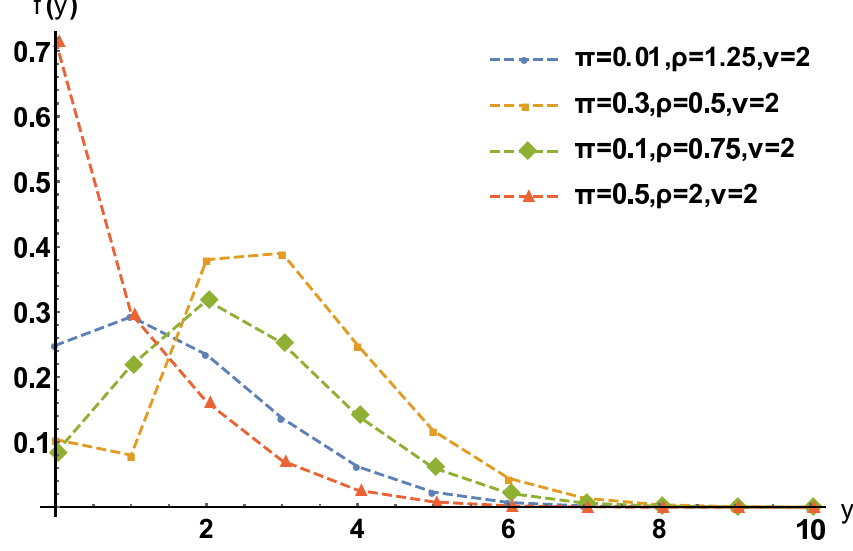
Figure 2 – Plots of probability mass functions of ZIAHPD for different values of π and ρ